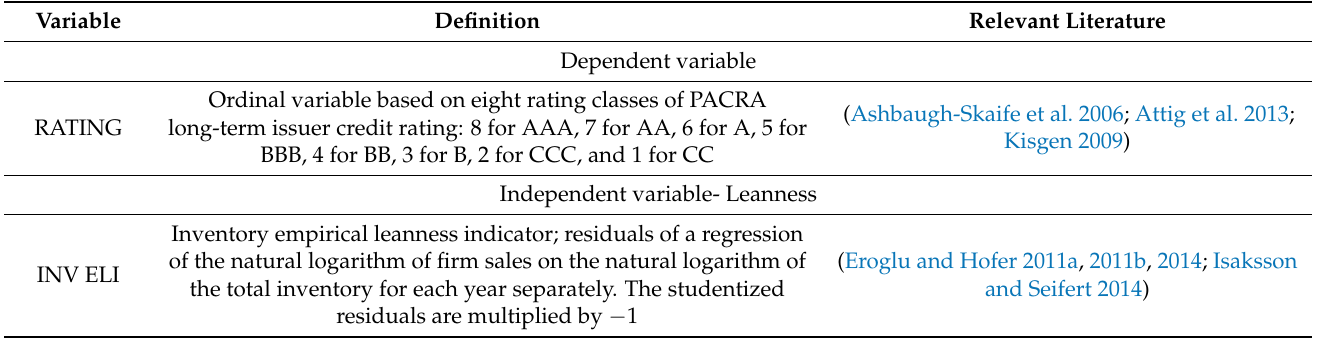
Table 1. Variable Table 1. Variable definitions.